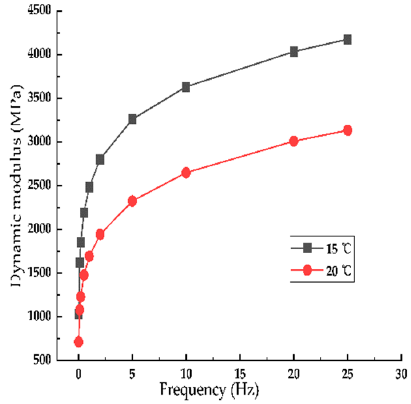
Figure 11. Dynamic modulus test results of F/RAP CRM.